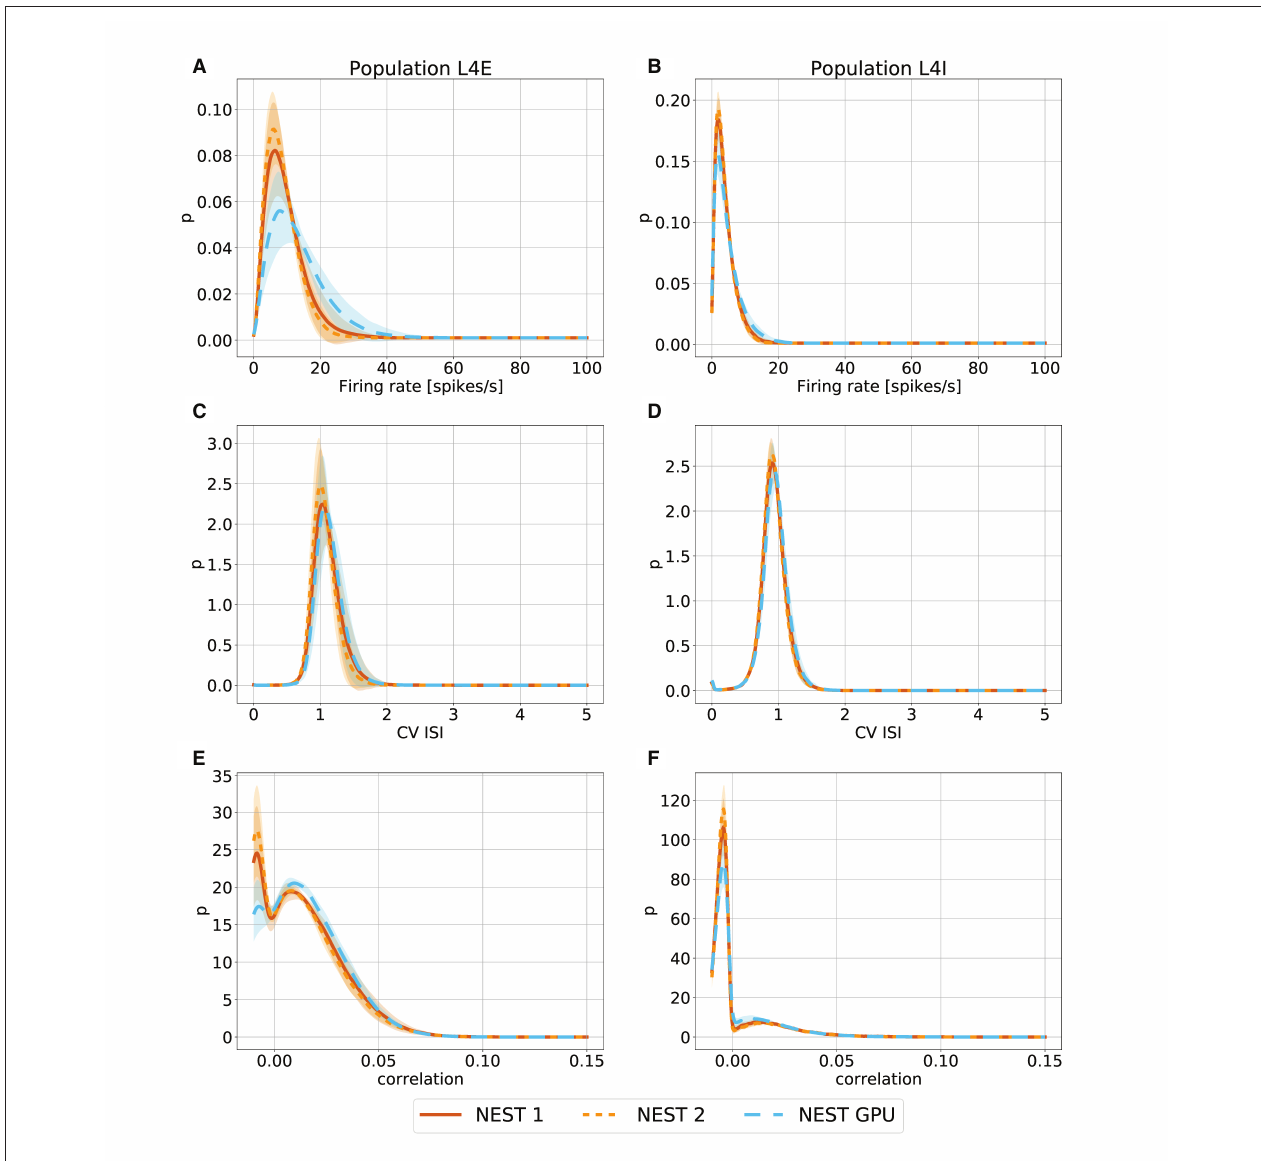
FIGURE 4 | Metastable state distributions of firing rate (A,B) , CV ISI (C,D) and Pearson correlation of the spike trains (E,F) for the populations L4E and L4I of area V1. The distributions are averaged over 10 simulations with NEST (orange lines) and NEST GPU (sky blue dashed line). Every averaged distribution has an error band representing its standard deviation. An additional set of NEST simulation distributions is also